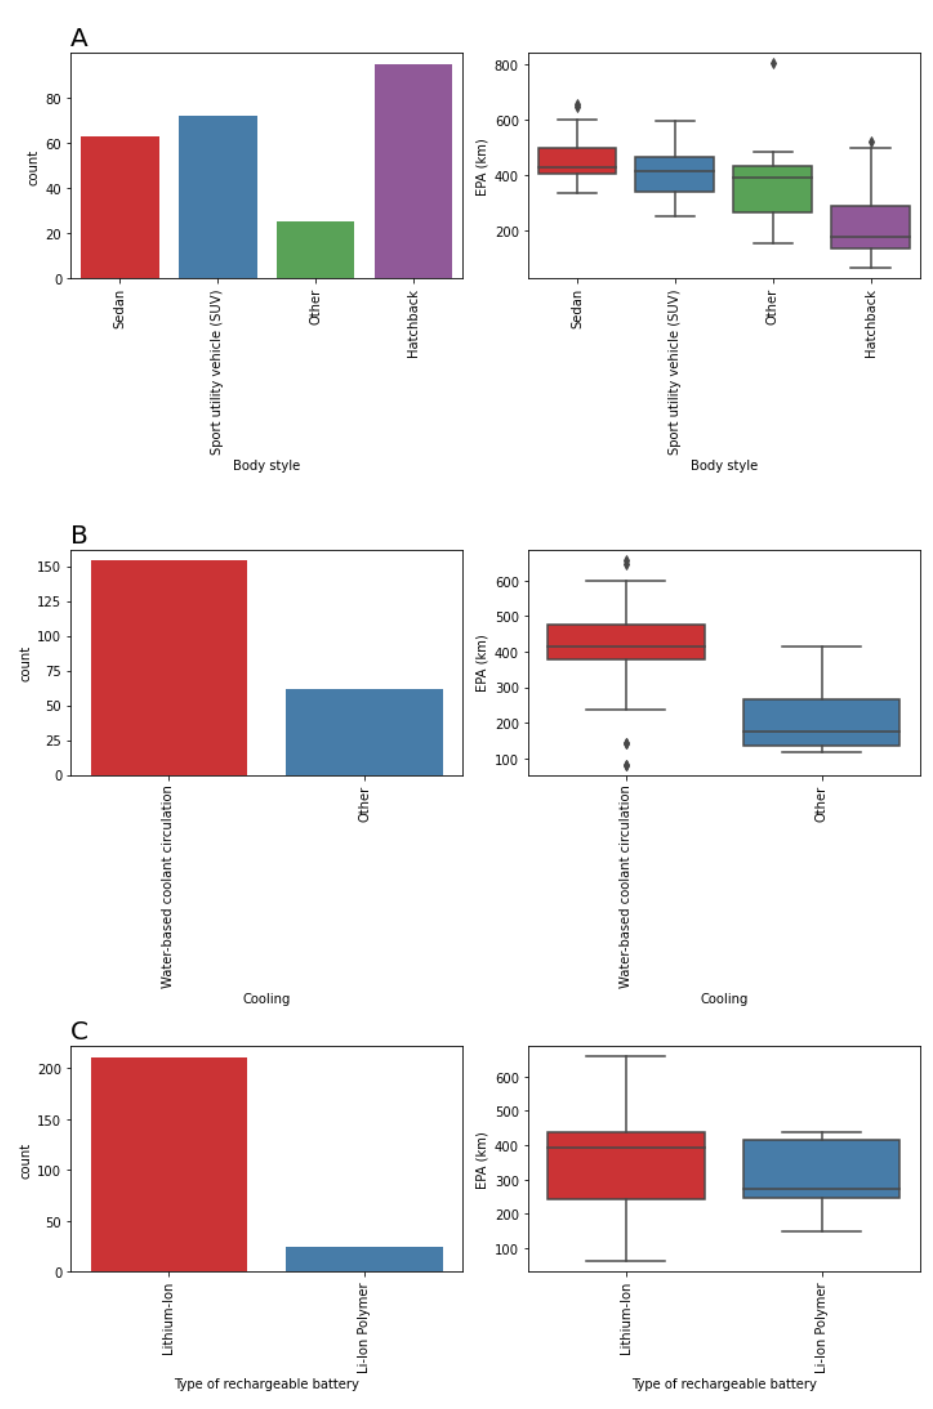
Figure 6. Histograms and boxplots of ( A ) EV body style, ( B ) battery cooling mechanism, and ( C ) type of lithium-ion battery used. The histograms plot the frequency (referred to as the count) of data points against the qualitative independent variables. Boxplots display the average and quartiles of the EPA range against the qualitative independent